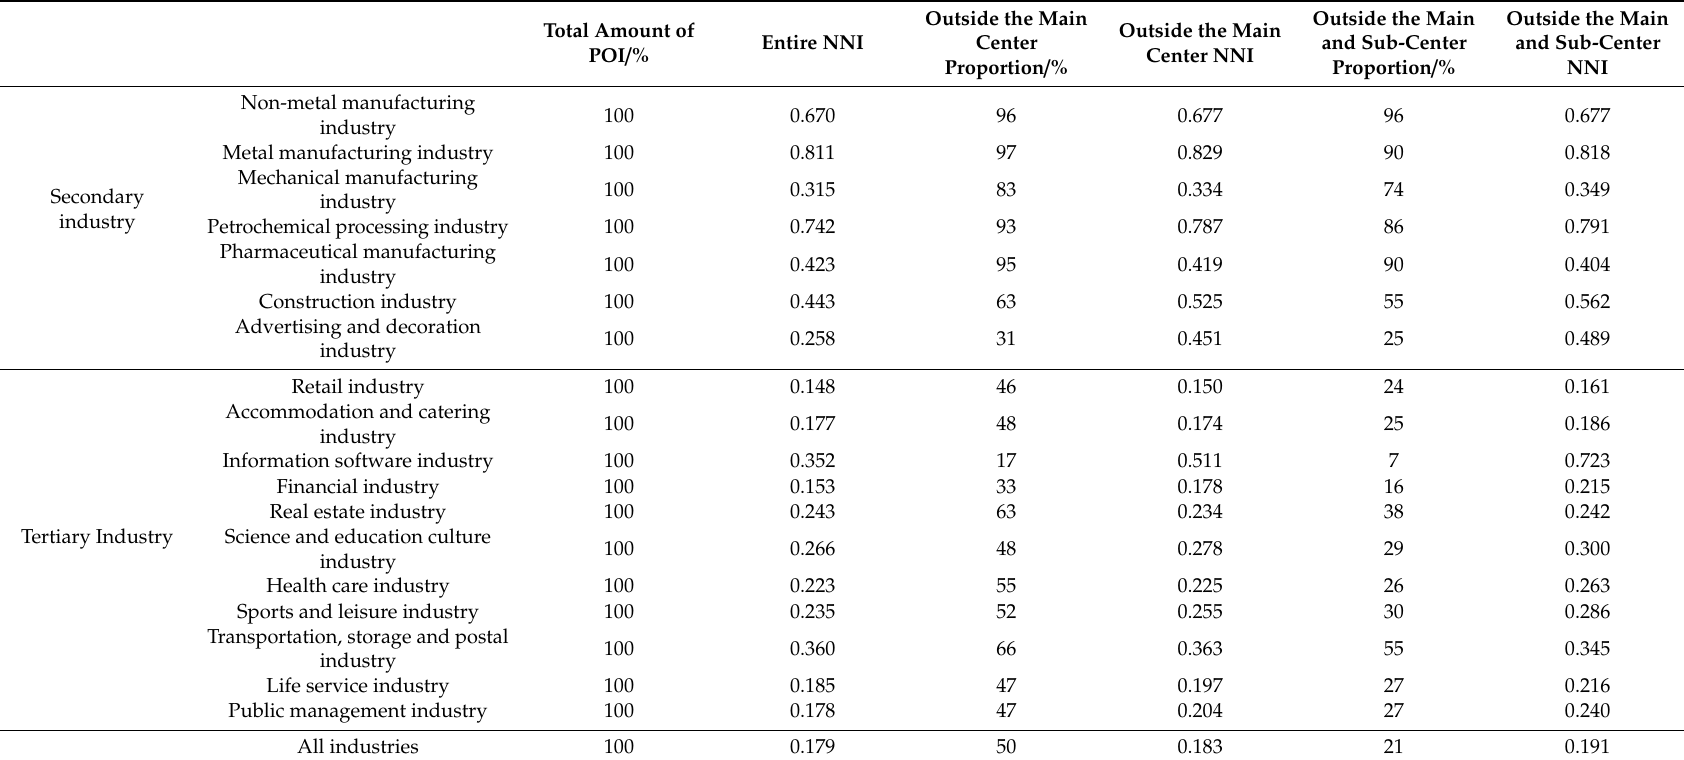
Table 2. The nearest-neighbor analysis results of